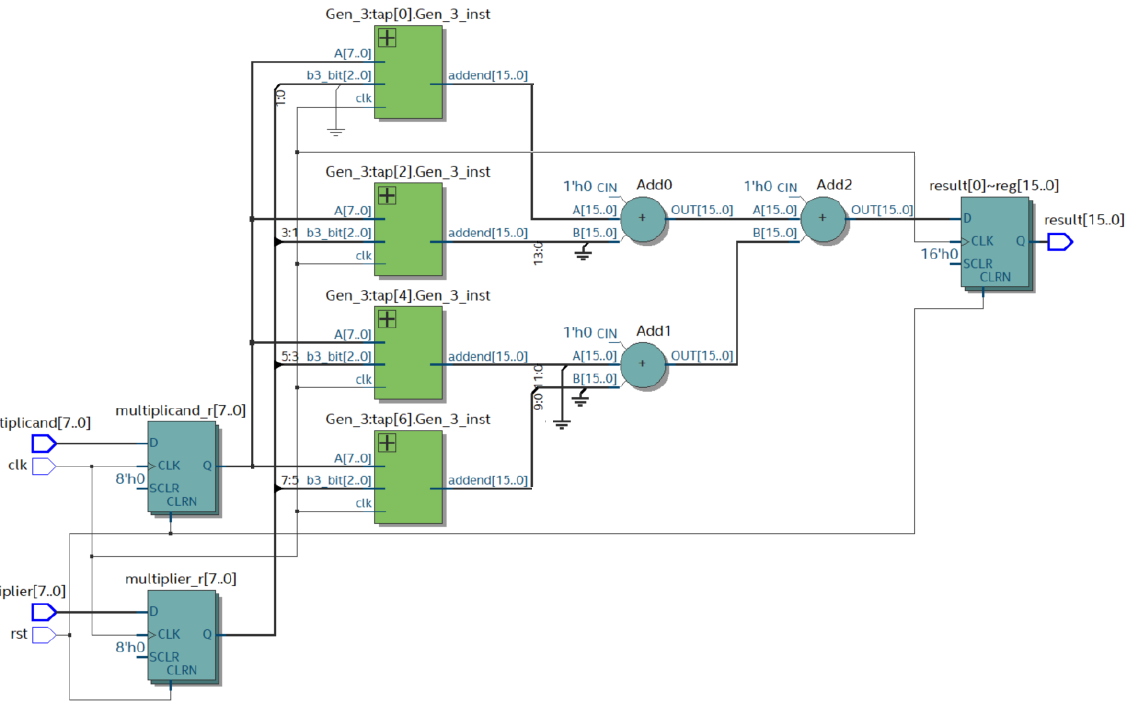
Figure 6. RTL hardware implementation of the modified Booth’s algorithm synthesized by Quartus Prime for n = 8.